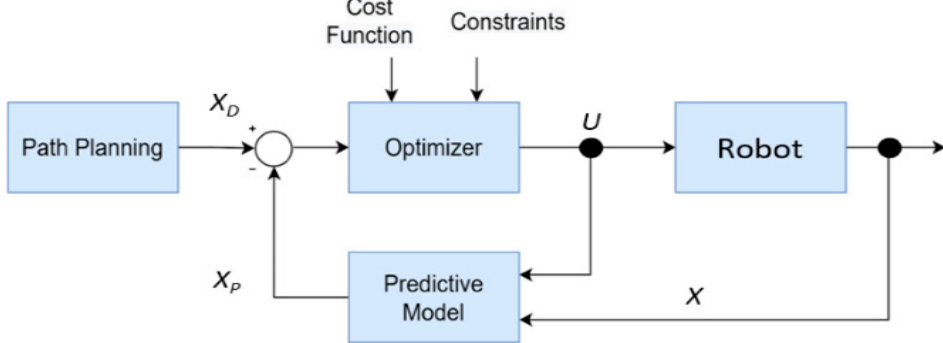
Figure 8. System block diagram for the proposed MPC-based controller.